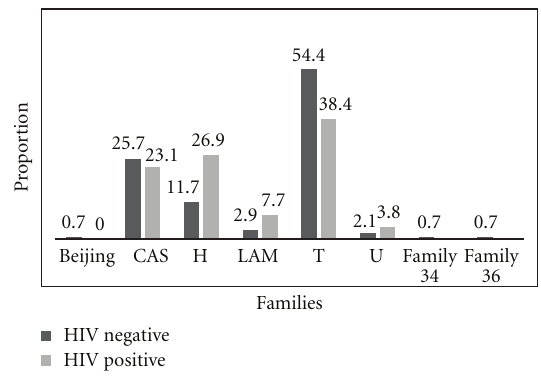
Figure 4: M. tuberculosis spoligotype families in HIV-positive and HIV-negative